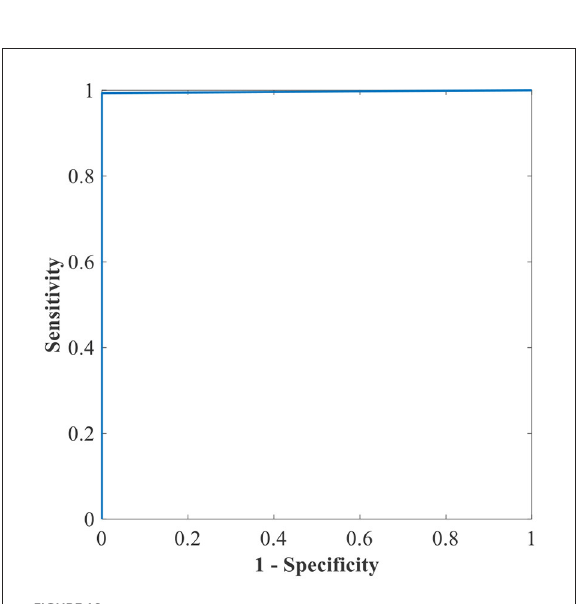
FIGURE10 The ROC of the highest binary classification outcome for the GWO-ELM approach using the APTOS-2019 dataset.